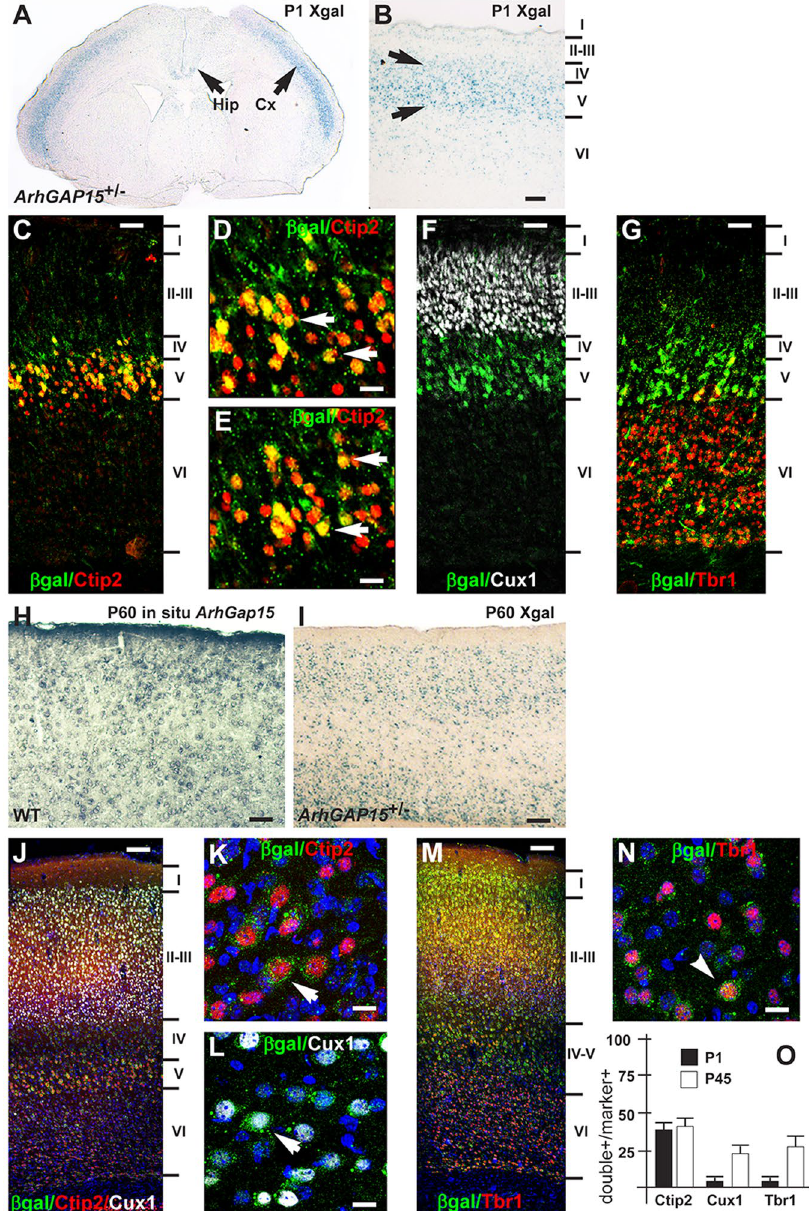
Figure 1. Expression of ArhGAP15 in early postnatal and adult mouse brain. ( A , B ) Xgal staining of coronal sections of the ArhGAP15 + / − brain, at postnatal day 1 (P1). In ( A ), low magnification; in ( B ), a higher magnification of the somatosensory area. Cortical layers are indicated on the right. Signal is detected mainly in layer V. Scale bar in B = 60 μ m. ( C – G ) Immunostaining of the somatosensory cortex of ArhGAP15 + / − brains, at P1, with anti- β gal (e.g. ArhGAP15, green cytoplasmic stain) and either Ctip2 ( C , D , E , red nuclear fluorescence), Cux1 ( F , white nuclear stain) or Tbr1 ( G , red nuclear stain) pyramidal markers. In ( D ) and ( E ), higher magnification from the image in ( C ). Double-stained neurons were observed only with Ctip2 ( C – E ), indicated with white arrows. Scale bars in C,F,G = 50 μ m, bar in D,E = 20 μ m. ( H ) RNA::RNA in situ hybridization to detect the ArhGAP15 mRNA in coronal sections of the somatosensory cortex of young adult (P60) WT animals. Scale bar = 50 μ m. ( I ) Xgal staining of coronal sections of the somatosensory cortex from ArhGAP15 + / − P60 animals. Scale bar = 60 μ m. ( J–N ) Characterization of β gal-expressing (green cytoplasmic staining) pyramidal neurons in ArhGAP15 + / − brains at the age P45, by double immunostaining with the layer-specific markers Ctip2 (red nuclear staining), Cux1 (white nuclear staining) and Tbr1 (red nuclear staining). ( J and M ) show low magnification images, with cortical layers indicated on the right. K,L and N show higher magnifications from the images on the left. Double-positive cells are indicated with white arrows. ( O ) Percentages of Ctip2-, Cux1- and Tbr1-positive pyramidal neurons that stain double-positive for β gal, at P1 (solid bars) and P45 (open bars). Quantification was done by section. Scale bars in J,M = 50 μ m, bar in K,L,N = 10 μ m. Data are presented as mean ±